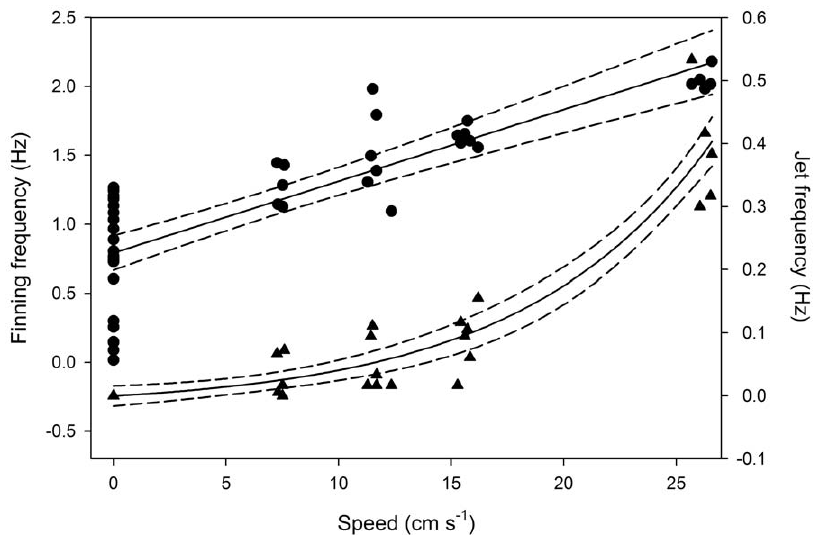
Figure 4. Relationships between swimming speed and frequency of finning (circles; see equation 2 in text) and propulsive jets (triangles; equation 3 in text) for giant Australian cuttlefish Sepiaapama . Dashed lines represent 95% confidence intervals.